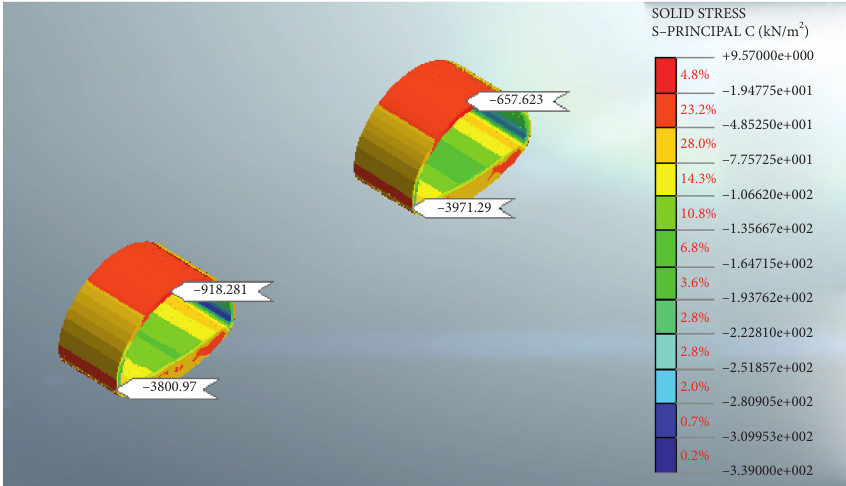
Figure 16: Second lining stress distribution in double-side guide pit method.